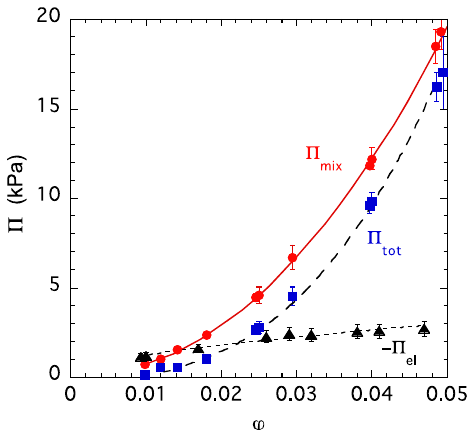
Figure 3. Variation in the swelling pressure Π tot and its osmotic Π osm and elastic Π el components with the volume fraction of the polymer in a PA gel swollen in 40 mM NaCl solution.